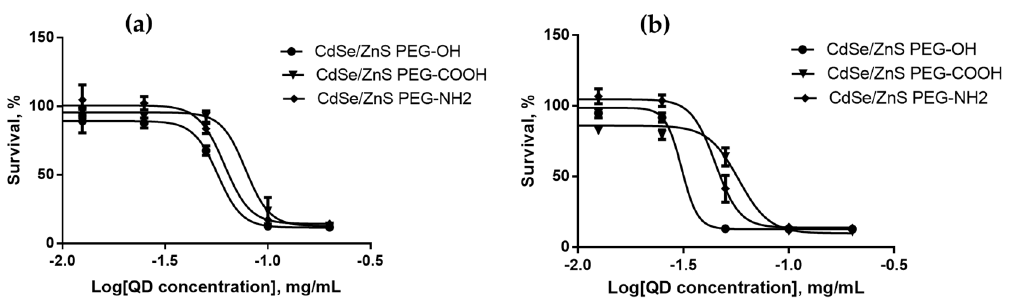
Figure 6. Survival of Wi-38 cells upon interaction with CdSe/ZnS-PEG-OH, CdSe/ZnS-PEG-COOH, and CdSe/ZnS-PEG-NH 2 QDs for ( a ) 24 and ( b ) 48 h as dependent on the QD concentration.